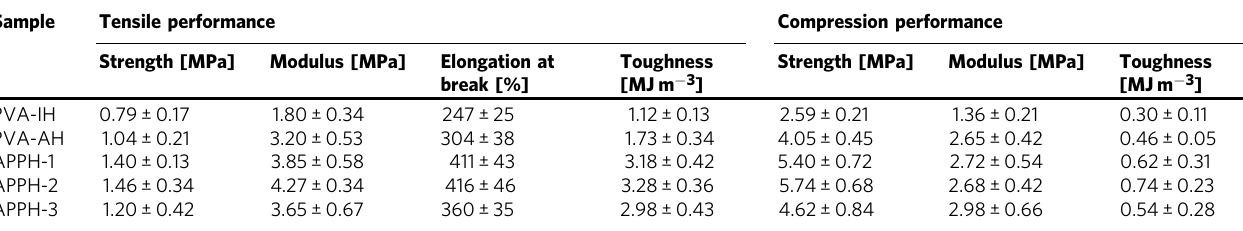
Table 1 Summary of mechanical properties of neat polyvinyl alcohol and anisotropic polyvinyl alcohol/polyaniline hydrogels.